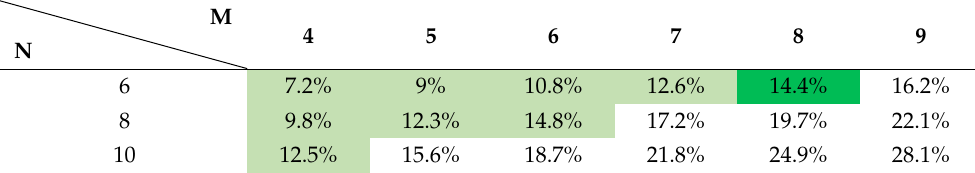
Table 1. Coverage area ratio of textures with different M and N .